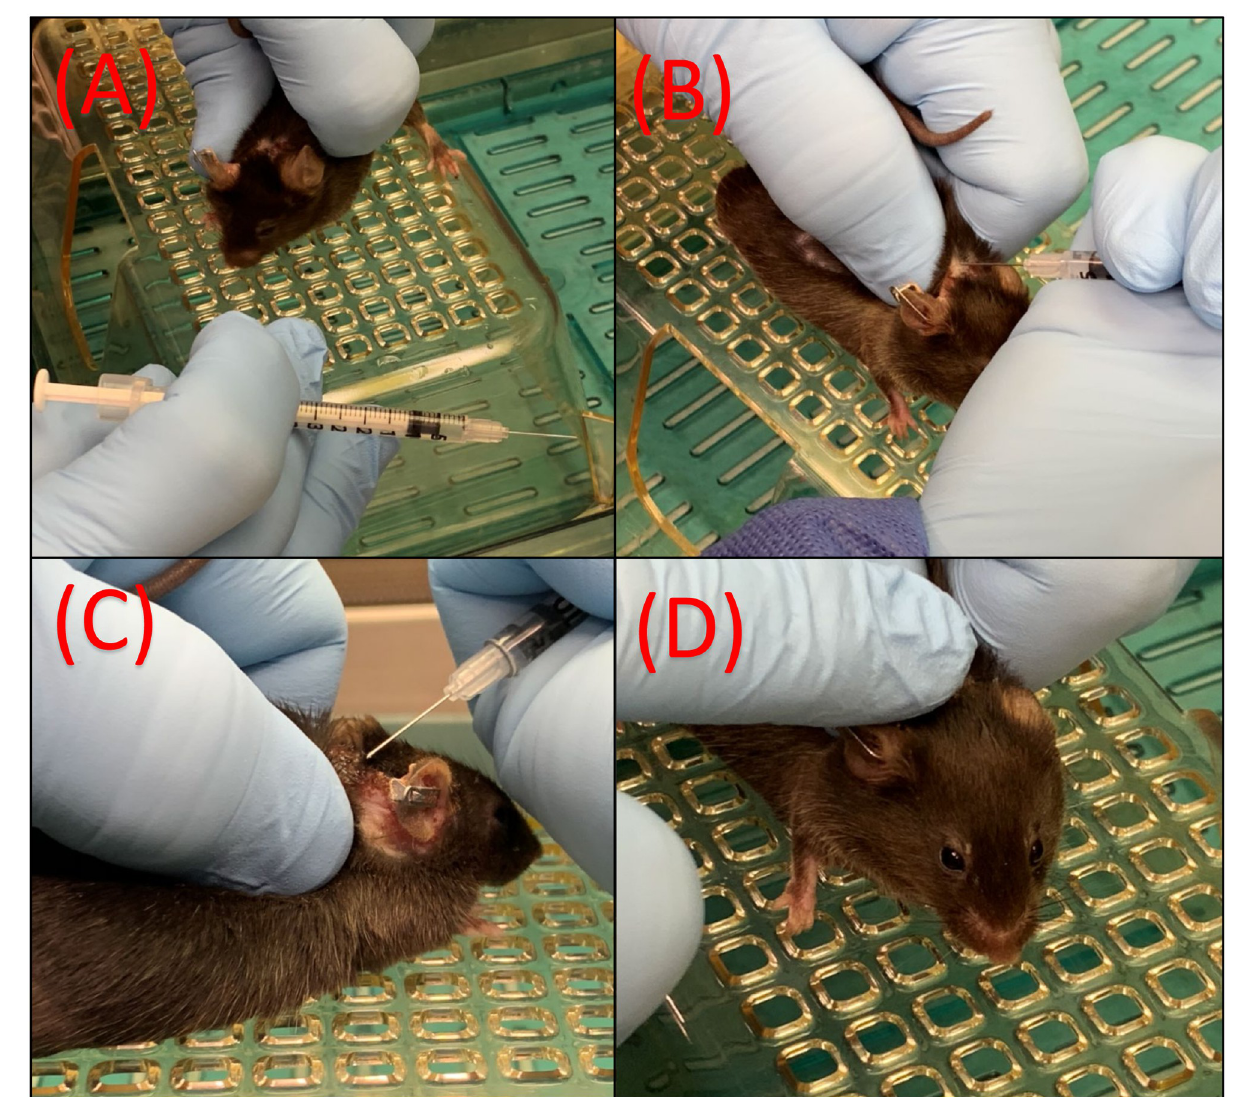
Fig 2. Topical administration of oclacitinib. (A) 50uL of 0.5% oclacitinib is draw up into an insulin syringe. The mouse is manually restrained, exposing any UD skin lesions. (B) The oclacitinib is dispensed onto the skin lesion. (C) Side profile showing application topically onto the skin lesion. (D) A gloved finger is used to disperse the liquid over all visible